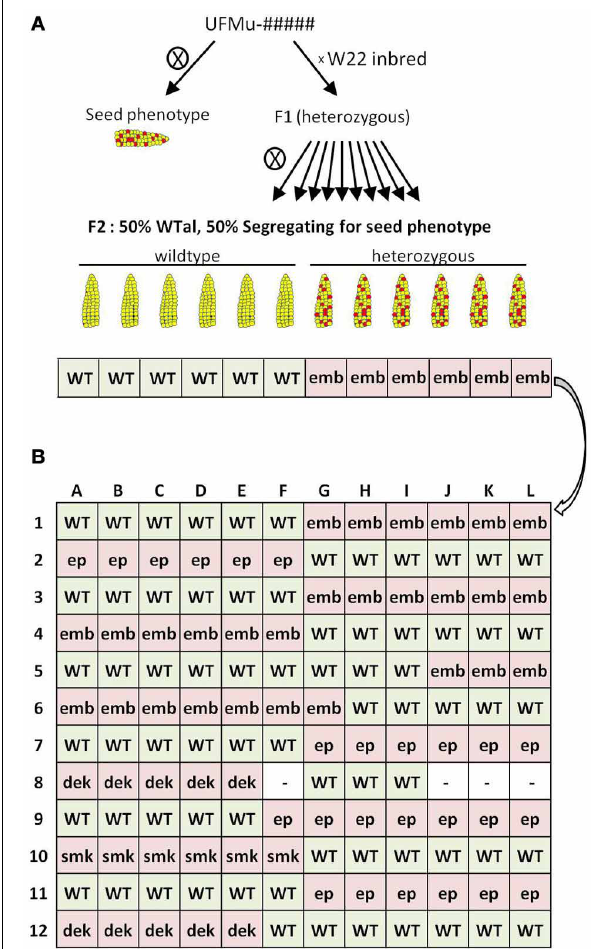
FIGURE 1 | Genetic strategy and grid design for forward-genetics Mu-seq. (A) UniformMu families segregating for seed phenotypes were selected for inclusion in the forward-genetics Mu-seq grid. For selected families, individuals were backcrossed to the W22 inbred, followed by selfing of the F1 progeny. Resulting ears were examined for the phenotype of interest, and scored as positive or negative. The expected ratio of ears with and without visible phenotypes was 50%. (B) Leaf samples from mothers of the phenotyped ears were pooled according to the diagramed grid design, such that pools 1 through 12 represented twelve individuals from a single family, and pools A through L represented a single individual from each family. DNA was extracted from the resulting 24 pools of leaf samples, sequencing libraries were constructed with each pool being assigned a specific key-code identifier, and Mu flanks were sequenced using a single Illumina flow cell. Seed phenotype abbreviations: embryo lethal (emb), empty pericarp (ep), small kernel (smk), defective kernel